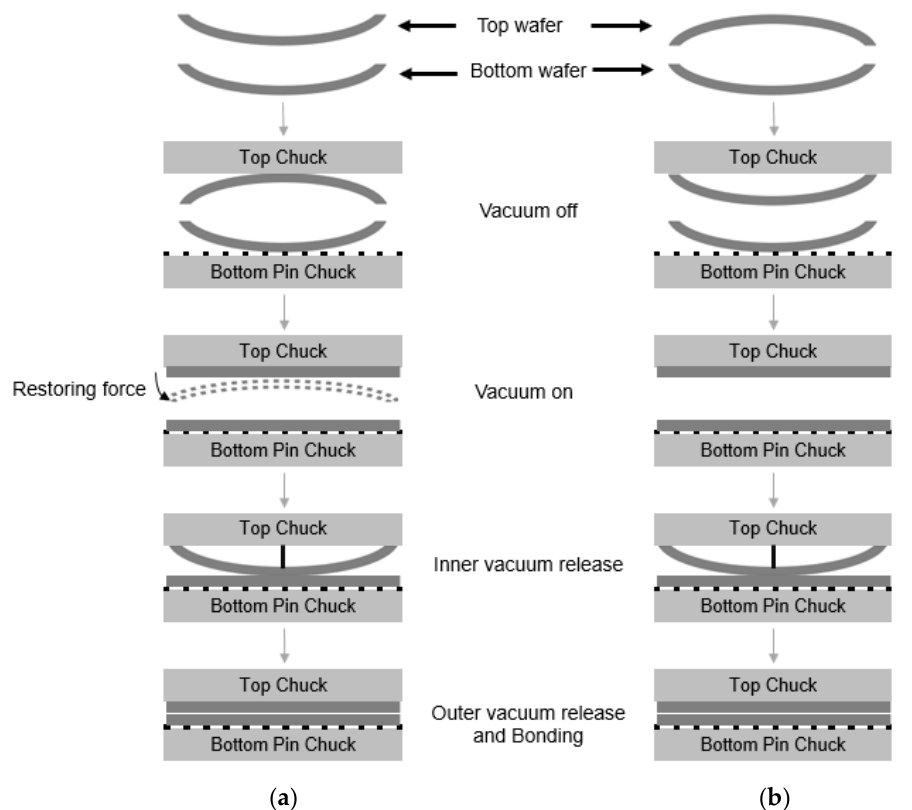
Figure 10. Schematic description of wafer bonding process. ( a ) Top wafer was originally deformed